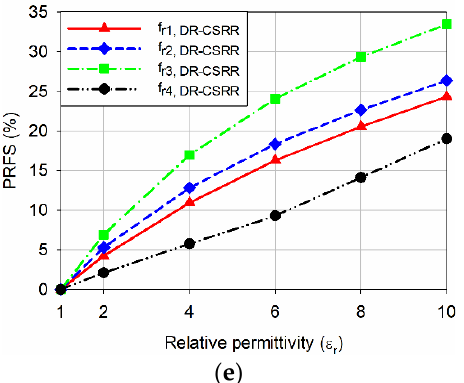
Figure 7. PRFS of the first four resonant frequencies for the reference and four slot-loaded MPAs when varying the relative permittivity of the MUT superstrate from 1 to 10: ( a ) the reference rectangular MPA, ( b ) the RS-loaded MPA, ( c ) the SR-CSRR-BCS slot-loaded MPA, ( d ) the SR-CSRR-TCS slot- loaded MPA, and ( e ) the DR-CSRR slot-loaded Table 2. Values of the first four resonant frequencies of the reference and four slot ‐ loaded MPAs when varying the relative permittivity of the MUT superstrate from 1 to 10 (in gigahertz). MPA Type ε r = 1